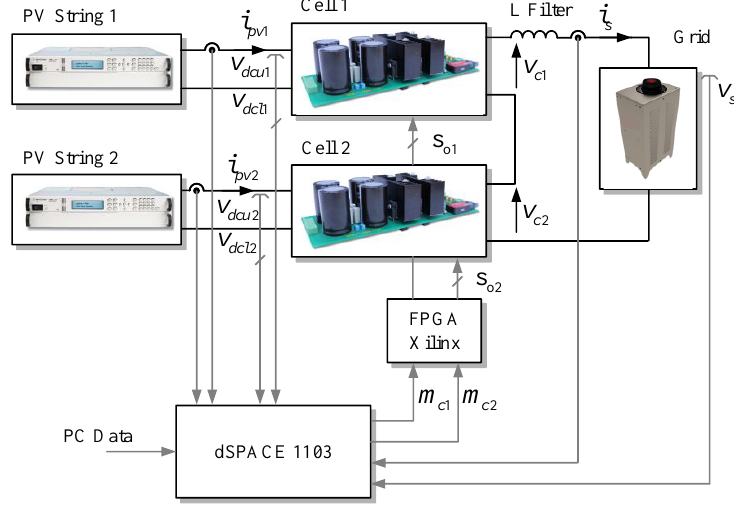
Figure 11. Simplified diagram of implemented experimental setup.